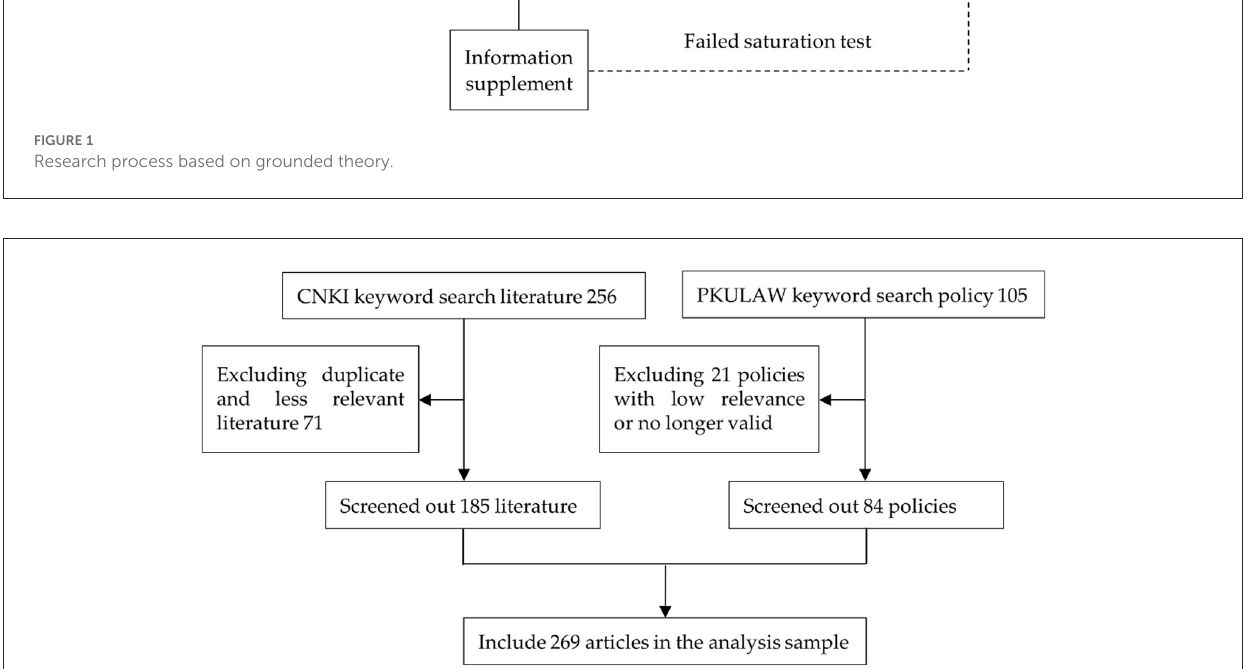
FIGURE2 Literature and policy text rooting data